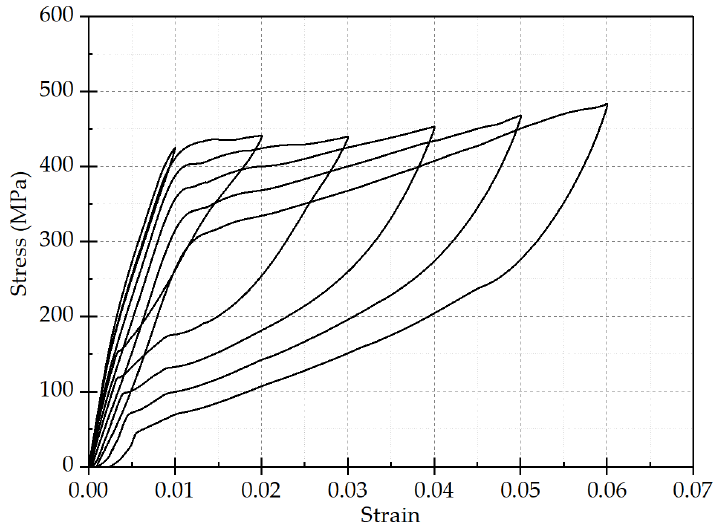
Figure 4. Stress–strain relationship curve of NiTi SMA bars under cyclic tensile load.